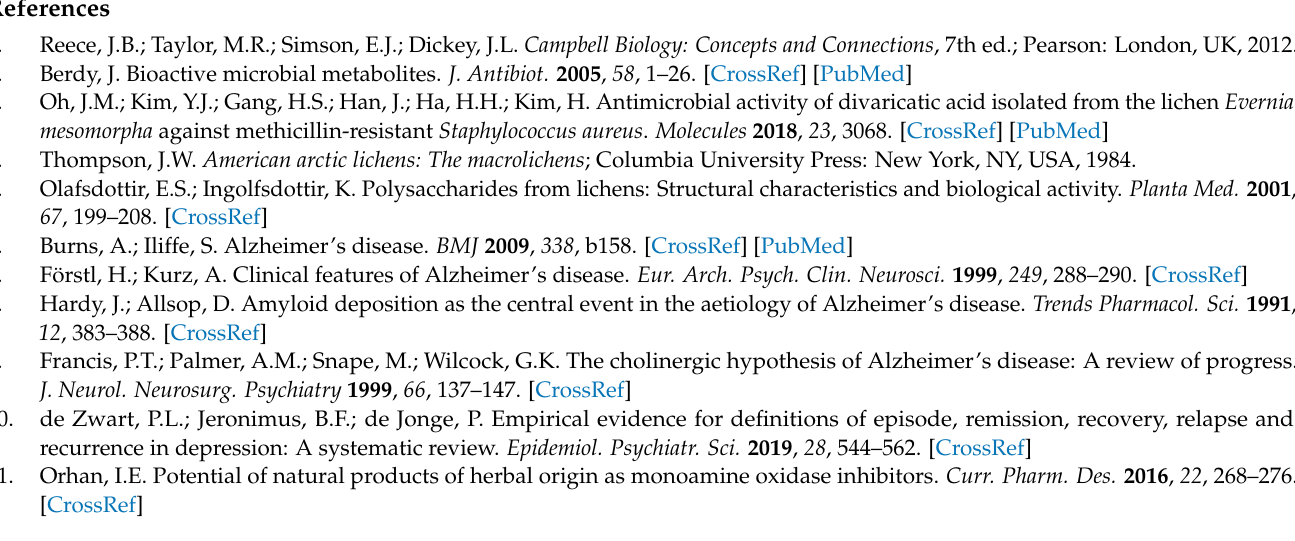
Figure S2: Inhibitory activity of ELF 195 extracts against MAO-B at 20 µ g/mL, Figure S3: Inhibitory activity of ELF 195 extracts against AChE at 50 µ g/mL, Figure S4: Inhibitory activity of ELF 195 extracts against BChE at 50 µ g/mL, Figure S5: Antioxidant activity of ELF 195 extract using DPPH at 100 µ g/mL, Figure S6: 1 H NMR spectrum of compound C2, Figure S7: 13 C NMR spectrum of compound C2, Figure S8: HMBC NMR spectrum of compound C2, Figure S9: LC/MS chromatogram of compound C2, Figure S10: Plots of root mean square deviation during 1000 ps MD simulation of MAO-B in complexes with ( R )- and ( S )-HMC, Figure S11: Plots of root mean square deviation during 1000 ps MD simulation of MAO-A in complexes with ( R )- and ( S